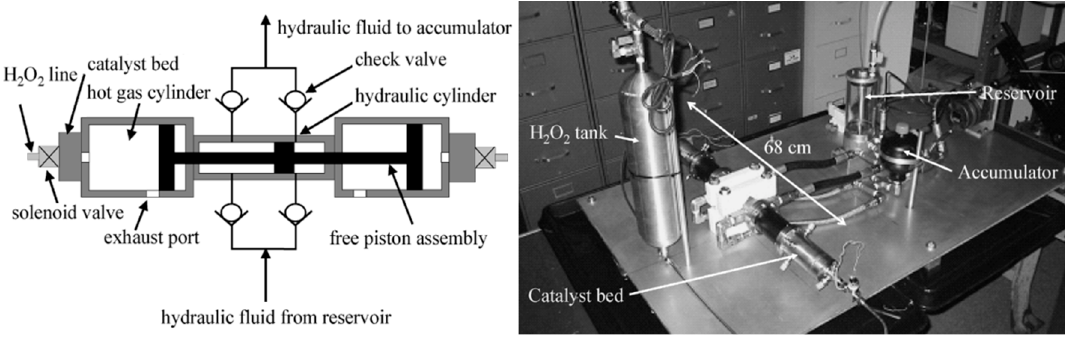
Figure 17. The dual-piston, free-piston engine prototype of the University of California [47,48].